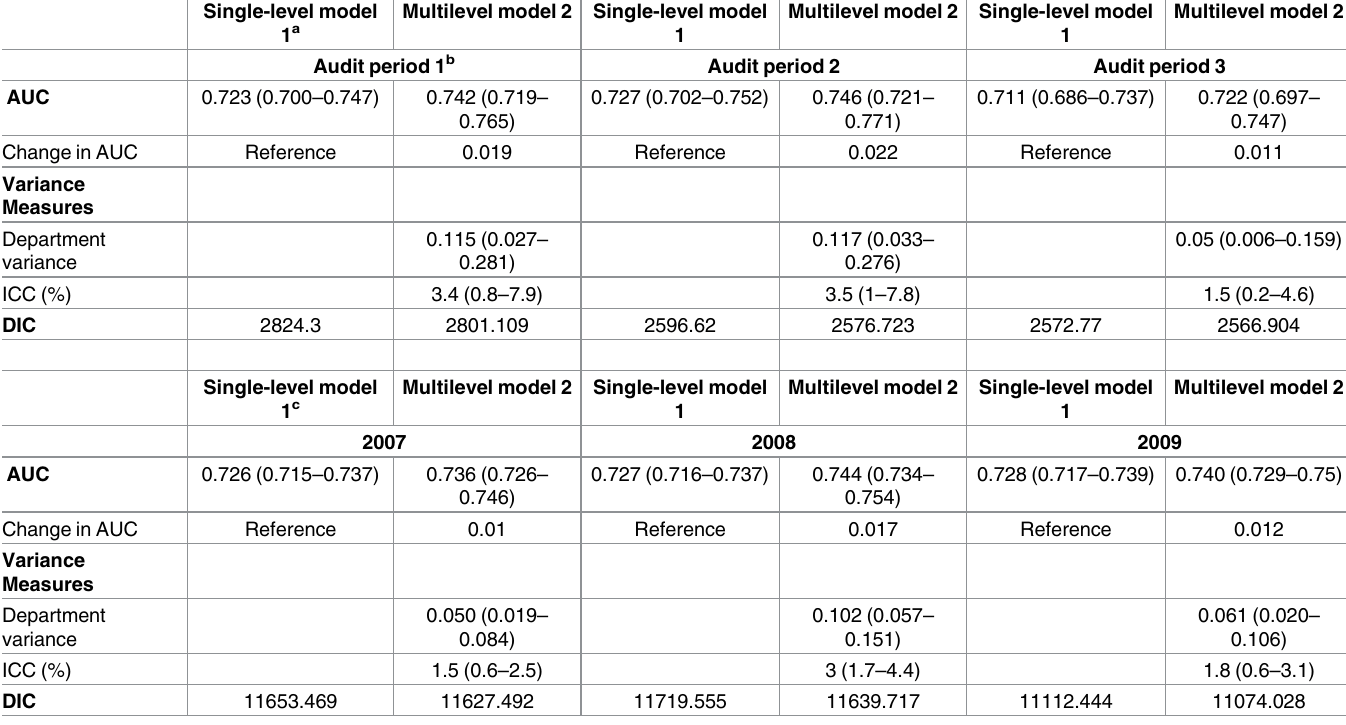
Table 3. Measuresof area under the receiveroperating characteristic curve (AUC) and measuresof variance(random effects) obtained by single- level logistic regression (model 1) and two-level (patients and hospital departments) multilevel logistic regression (models 2) modelling one-year mortality in patients treated in Danish and Swedish departments. Variancemeasuresare expressedas median values and 95% credible intervals (CI).